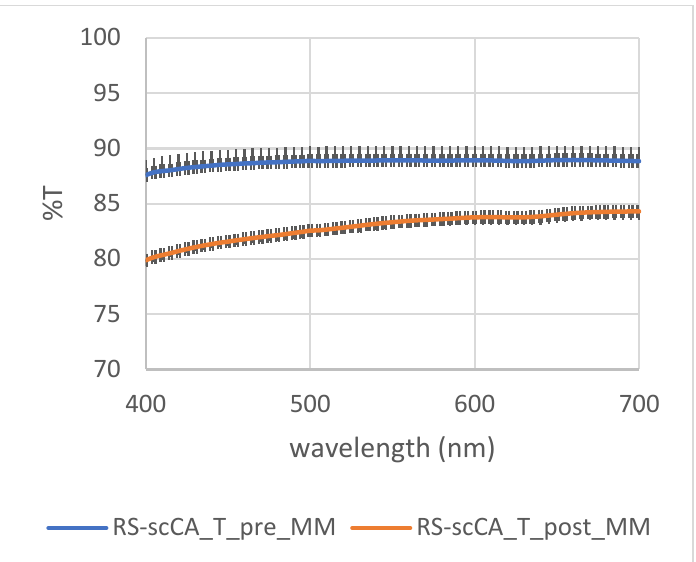
When it comes to comparing the same printer with the two different materials, it is clear that the transmittance curves are more constant with Zendura FLX. This result is an Figure 7. Comparison of transmittance values of the Scheu CA Pro + with Carbon L1 printer before indication of how aesthetics are preserved between T0 and T1. (Figure 9) and after aging. The curves are the average of nine spectrophotometry measurements ± SD.